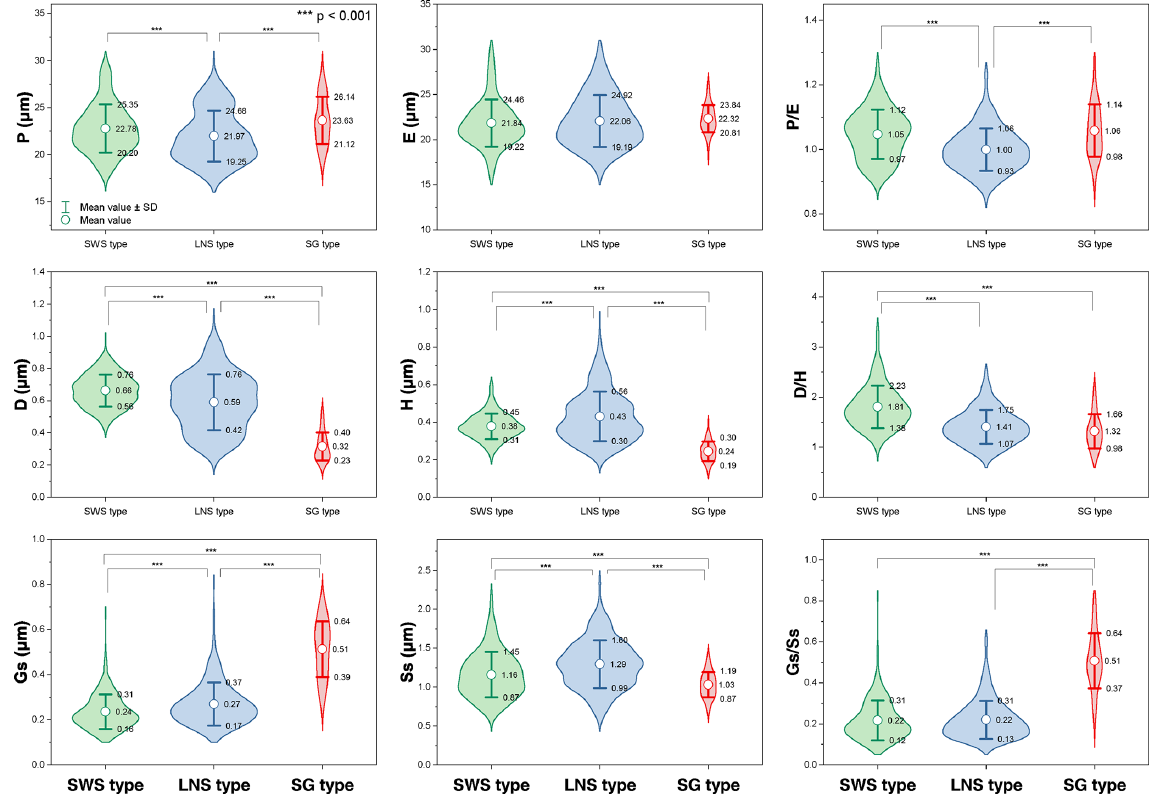
Figure 19. Violin diagrams of three pollen types from Artemisia , showing the variations (M ± SD) in nine pollen characters (P: length of polar axis; E : length of equatorial axis; D : diameter of spinule base; H : spinule height; Gs: granule spacing; Ss: spinule spacing; Ps: perforation spacing). Asterisks indicate statistically significant differences ( p < 0 . 001).